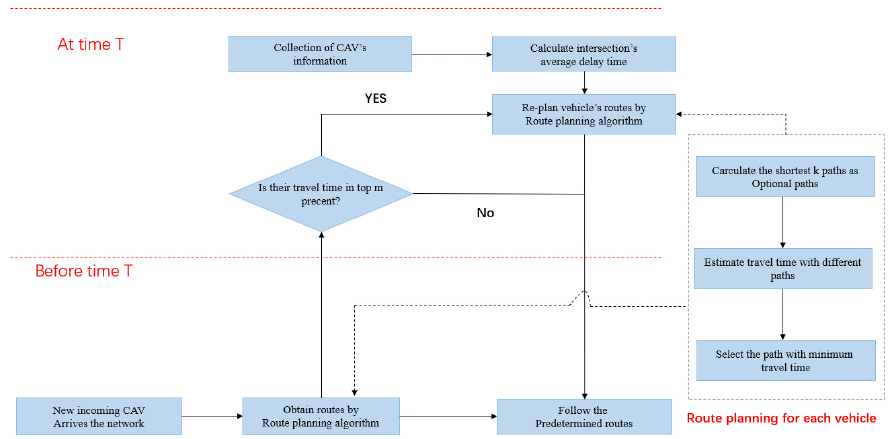
Figure 5. The process of the coordination strategy.